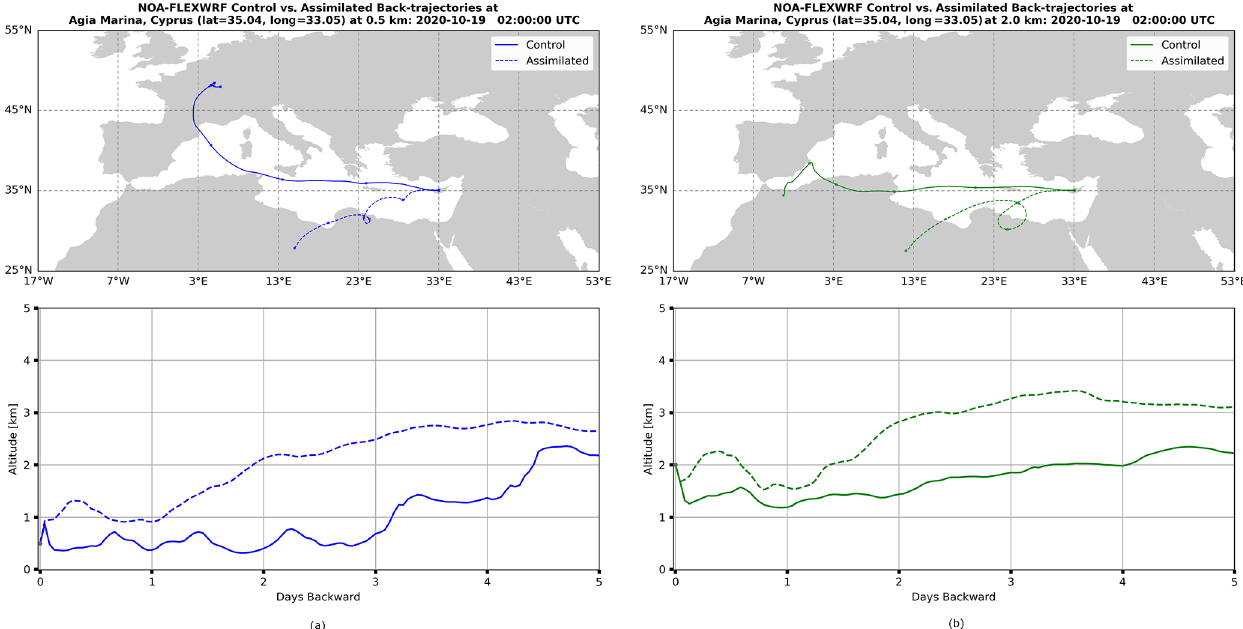
Figure 5. The top row depicts the FLEXPART backward trajectories for tracer particles arriving at the Agia Marina, Cyprus, station at 0.5km (a) and at 2km (b) on 19 October at 02:00:00UTC. The solid line represents the trajectory of the control run, and the dashed line represents the trajectory of the assimilated run. Additionally, the altitude inclinations of the particles are depicted in the bottom row. Table 2. Statistical comparison of filtered AERONET AOD observations to model outputs for all 56 AERONET stations and for selected